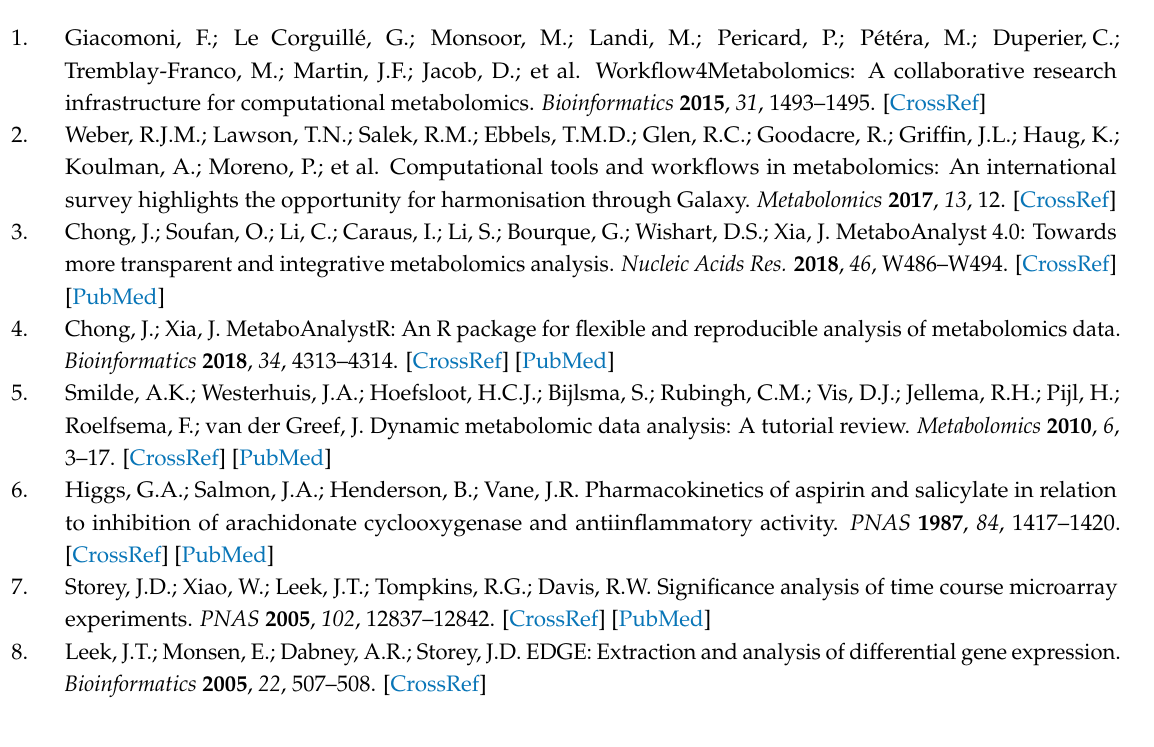
Figure S1: Generated biological network connectivity distribution, Table S1: Simulation parameters, Figure S2: Metabolomic network example, Figure S3: ROC curves for random forest, SVM and naive Bayes classifiers, Figure S4: Precision-Recall curve for the random forest classifier, Figure S5: Visualization of the full tinderesting app, Figure S6: Two examples from a dynamic metabolomics experiment, Figure S7: Feature scores of EDGE and tinderesting, Table S2: XCMS pre-processing parameter settings, Figure S8: ROC curve for tinderesting on expert-reviewed experimental